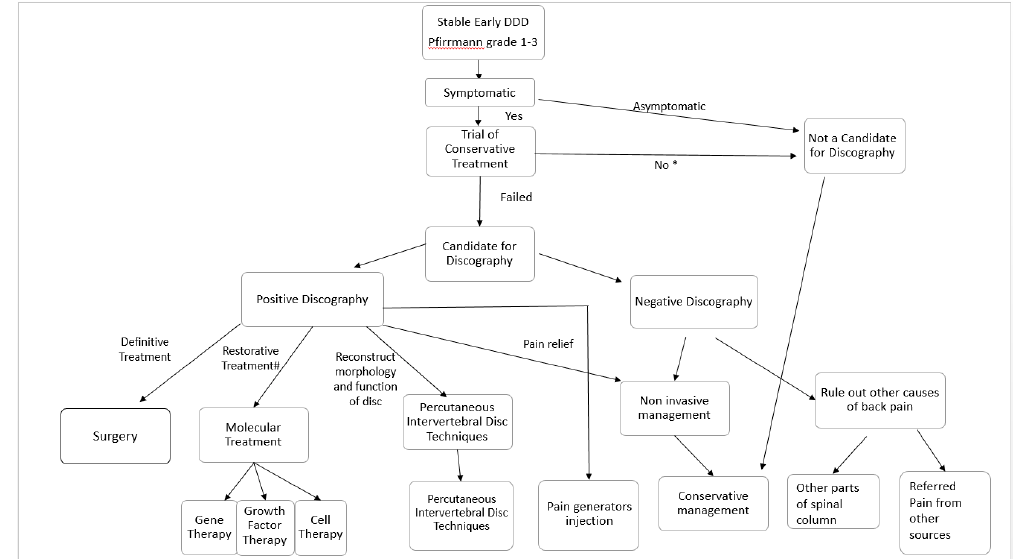
Figure 3. Decision flow chart in clinical practice for patients with stable early degenerative disc disease. Patients with early DDD manifested as Pfirmann grade 1–3 disc on MRI are assessed for